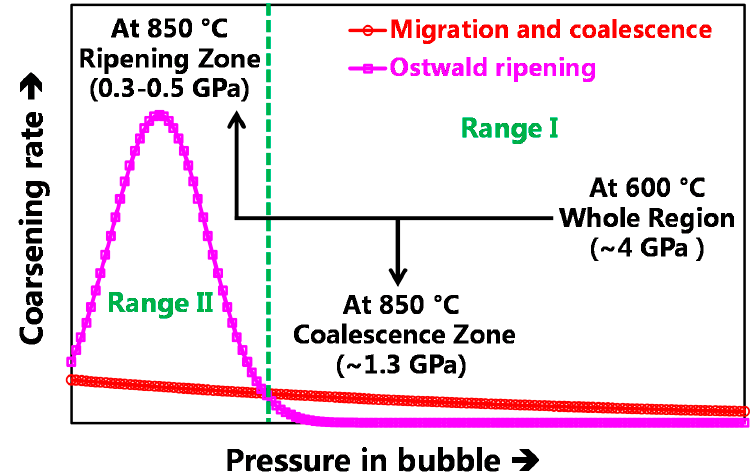
Figure 3. Schematic of the coarsening mechanisms (rate) driven by “Ostwald ripening” and “migration and coalescence” with the evolution of bubble pressure.